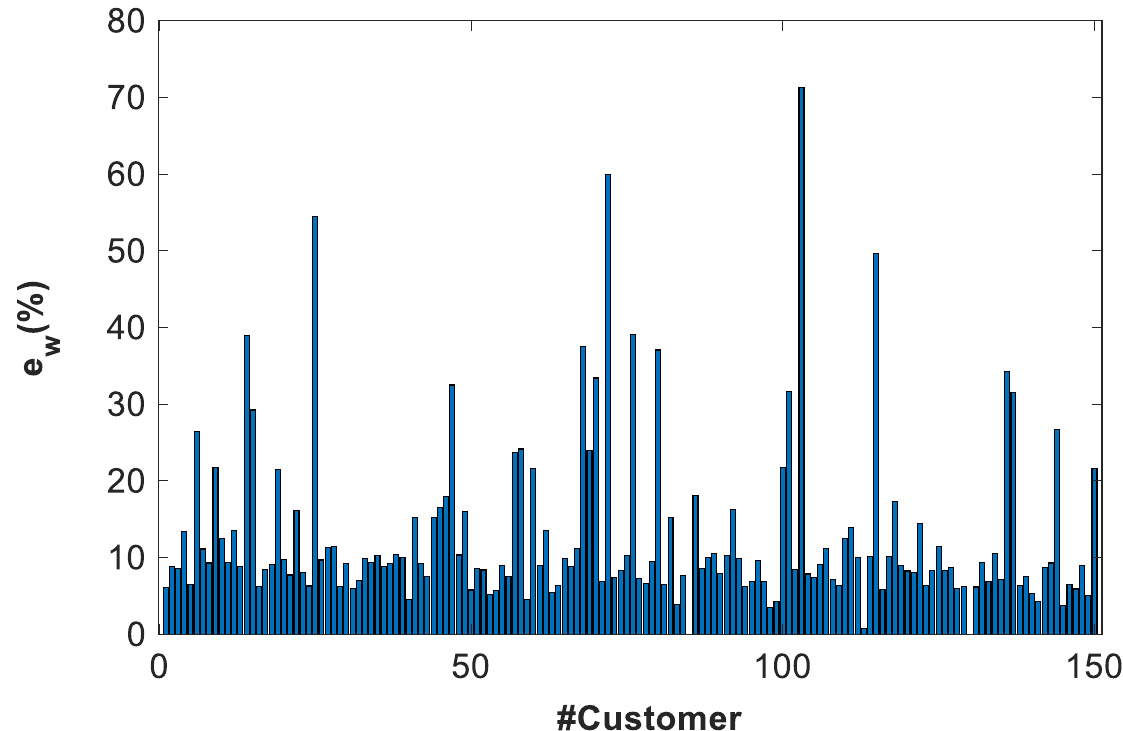
Figure 13. The partial error of the power profiles estimator, 𝑌̂ , obtained using the reference algorithm without the clustering phase. The error is normalized by normalized by the upper bound of the contractual power of the subset of considered power profiles (i.e., P = 16.5 kW).